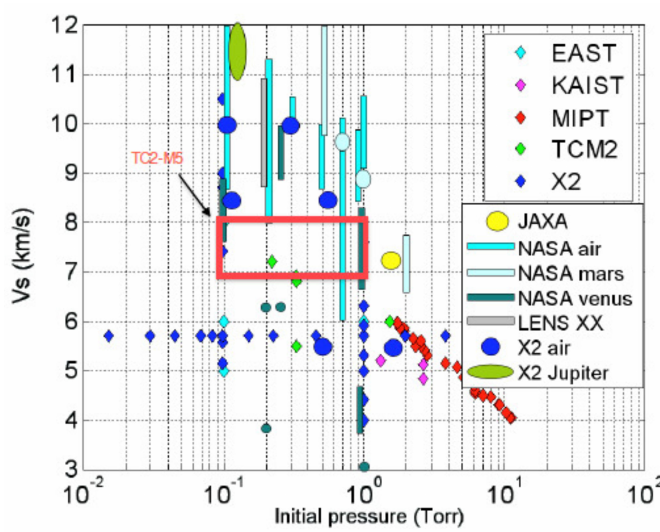
Figure 16. TC2 test conditions and facilities maps